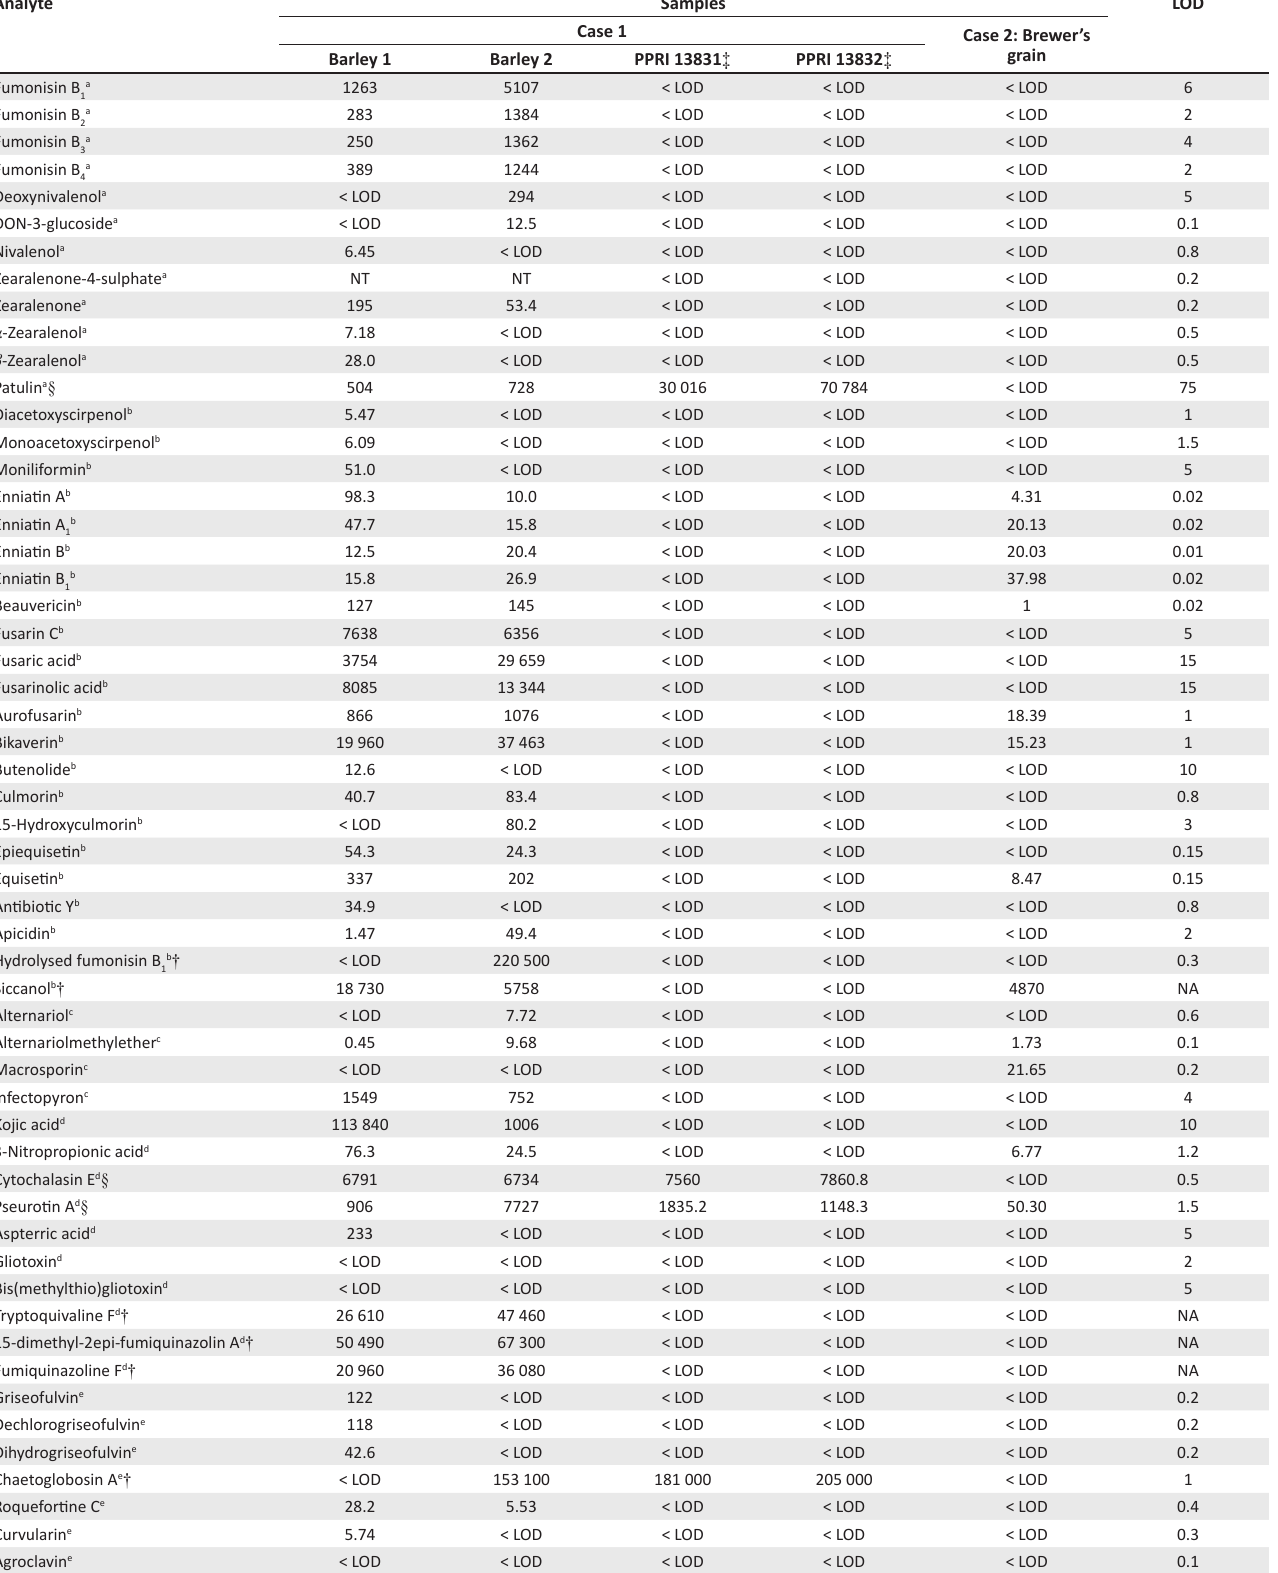
TABLE 1: Fungal metabolites and estimated concentrations ( μ g/kg) in feed samples and Aspergillus clavatus isolates.